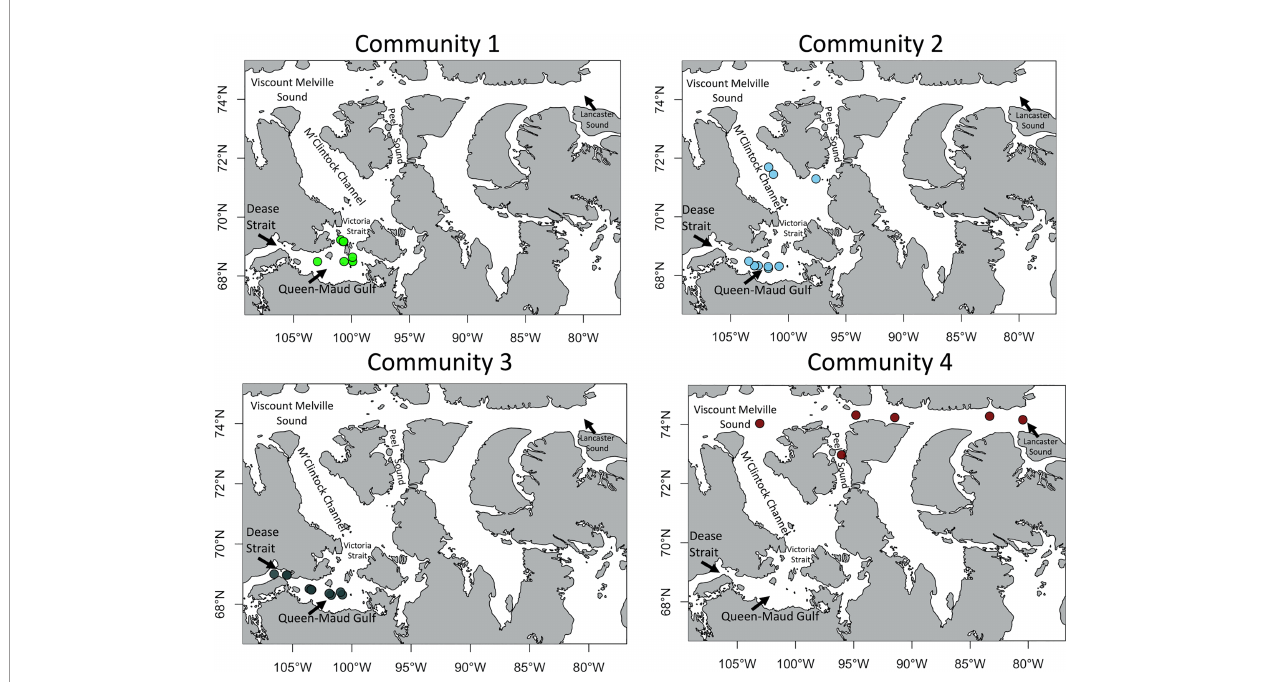
FIGURE 3 | Location of the 4 infaunal communities across the Kitikmeot Sea region and Parry Channel. Colors represent the communities assigned in Figure 2